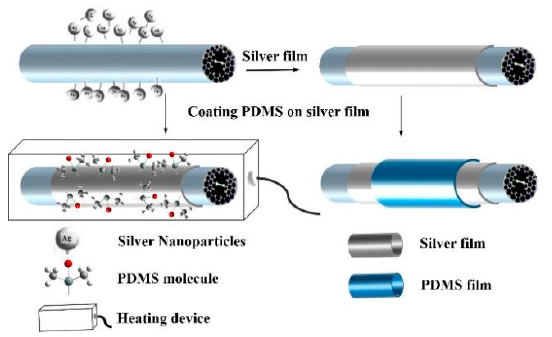
Figure 4. Pouring silver film and PDMS on the sensor and curing the